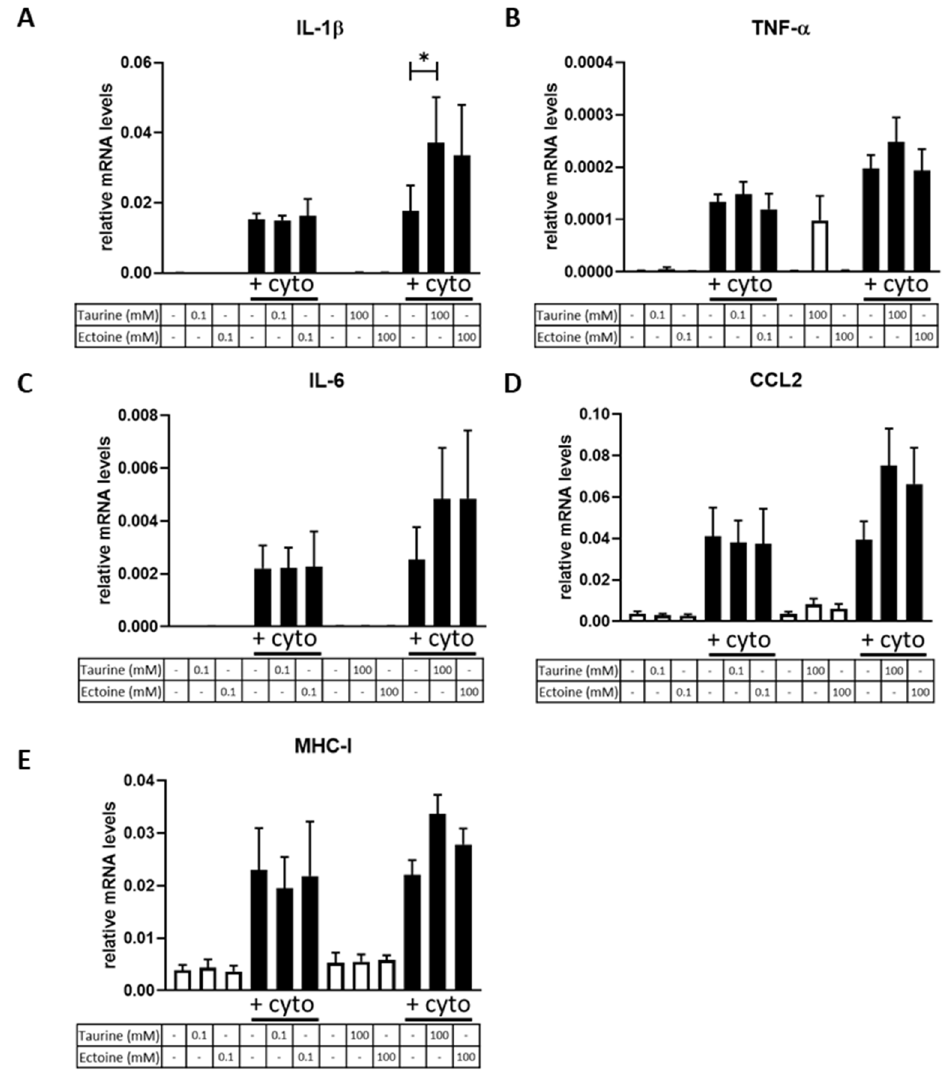
Figure 2. Relative gene expression of inflammatory markers in CCL-136 cells. CCL-136 cells were incubated in medium supplemented with 0.1 mM taurine, 100 mM taurine, 0.1 mM ectoine or 100 mM ectoine, whereas exposure to cytokines (IL-1 β + IFN- γ ) is annotated by ‘+cyto’. Graphs show mRNA levels of IL-1 β ( A ), TNF- α ( B ), IL-6 ( C ), CCL2 ( D ) and MHC-I ( E ) after exposure to different treatment conditions. In vitro cell experiments were conducted in triplicate and mean values are depicted in the graphs. Data underwent a log-transformation in order to adhere to normality assumptions. Relative gene expression is normalized to the housekeeping gene GAPDH and expressed as 2 −Δ CT , and data are presented as 2 −Δ CT mean ± standard error of the mean (SEM). Statistical analysis evaluated differences between untreated and treated samples within a specific condition (exposed/ not exposed). For clarity, only the significant differences between untreated and treated cytokine exposed samples are shown and were annotated by * ( p < 0.05).